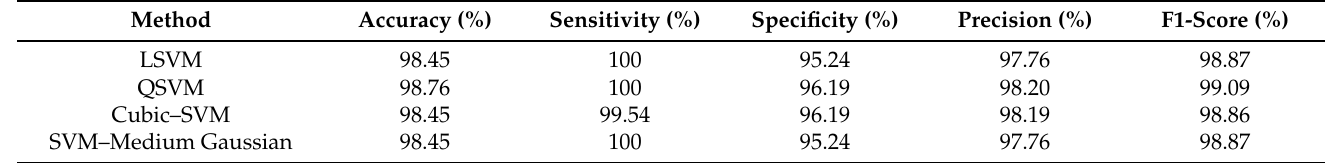
Table 10. DenseNet201 and CNN activated feature fusion-based classification using 10-fold cross-validation.